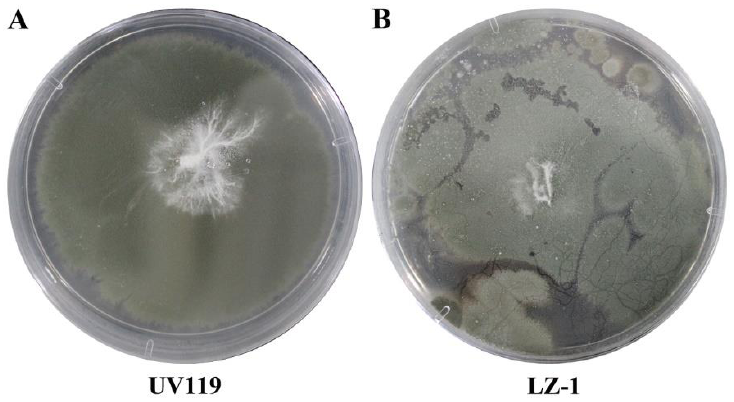
Figure 4. Growth of mutagenesis on PDA plate dominated by Trichoderma . LZ-1: Longzhi No.1. ( A ): UV119 grew on PDA plate with Trichoderma ; ( B ): LZ-1 grew on PDA plate with Trichoderma.